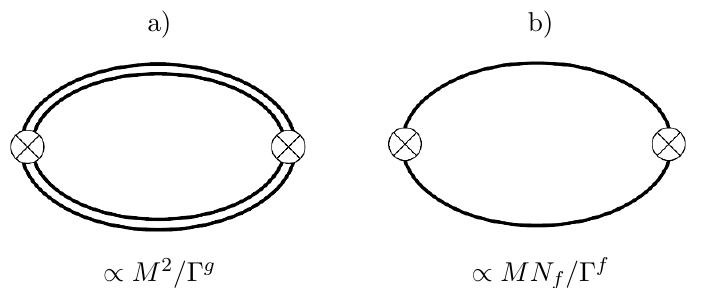
Figure 1 . One-loop contribution to the spectral function. a) gauge boson loop, b) fermion loop. The crossed vertices denote insertions of the full trace of the stress-energy